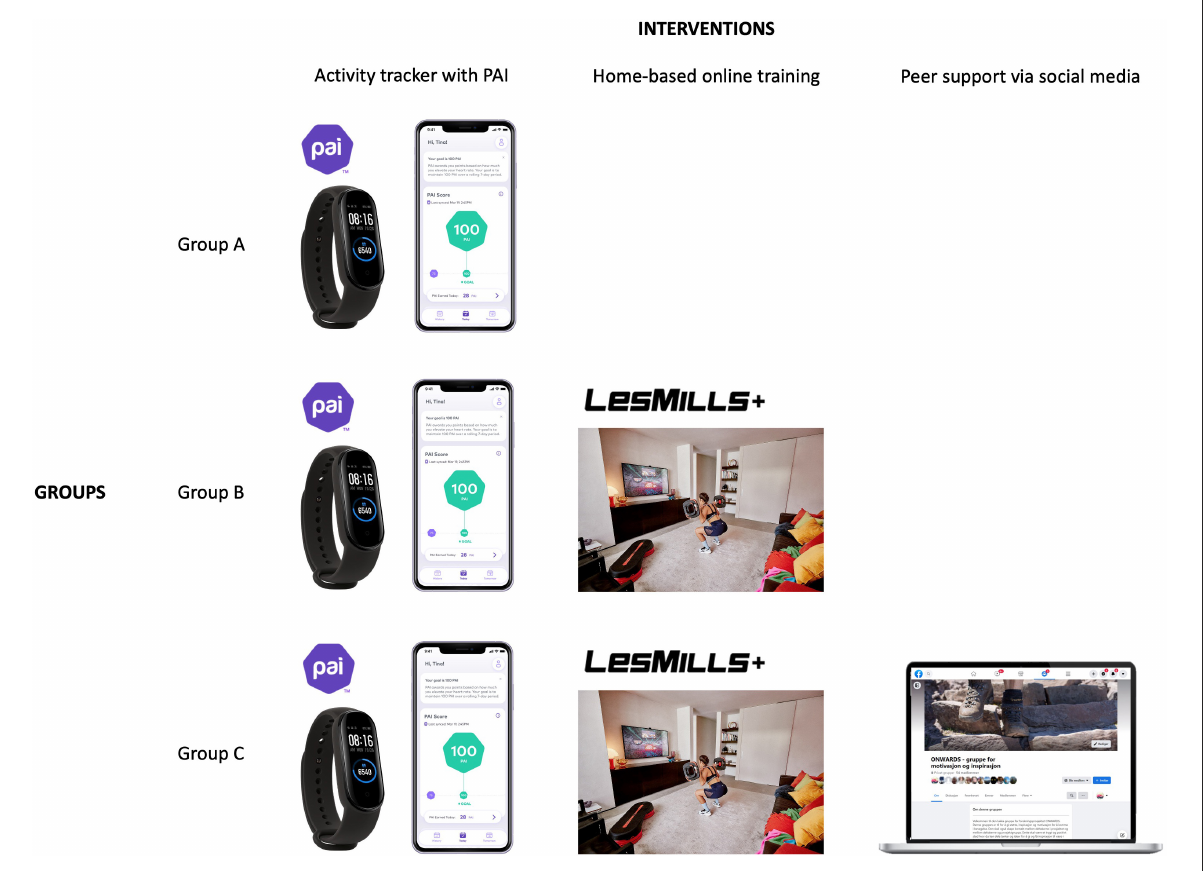
FIGURE1 Interventions provided to the three